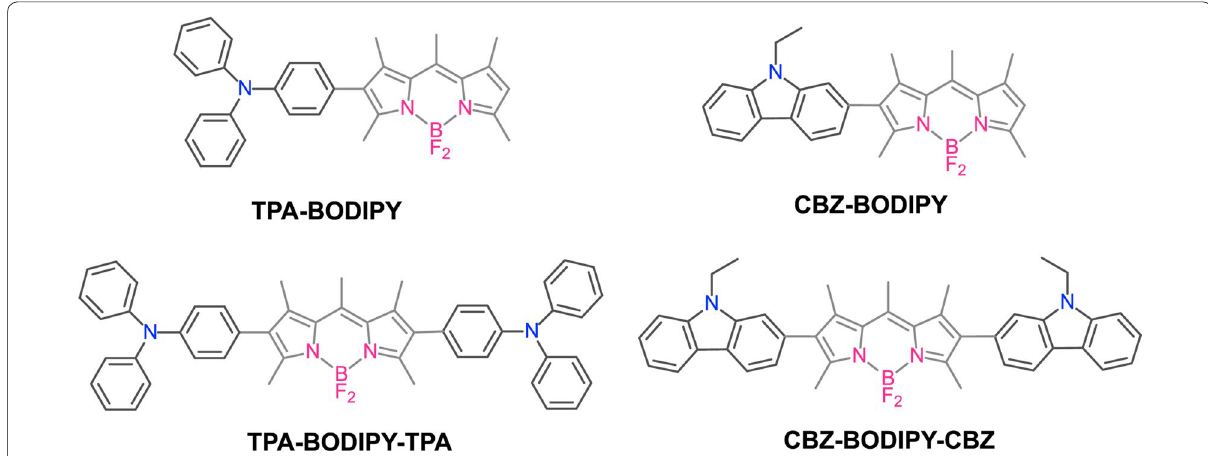
Fig. 1 Chemical structures of TPA-BODIPY , CBZ-BODIPY , TPA-BOIDPY-TPA and